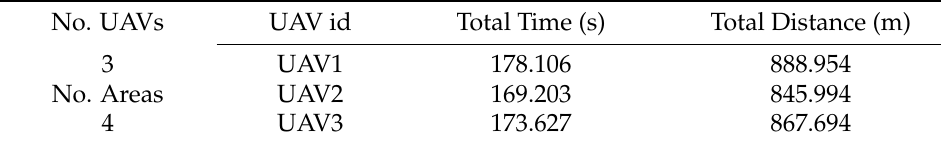
Figure 12. The simulation results of three drones in a swarm application. Table 2. Numerical results of the swarm